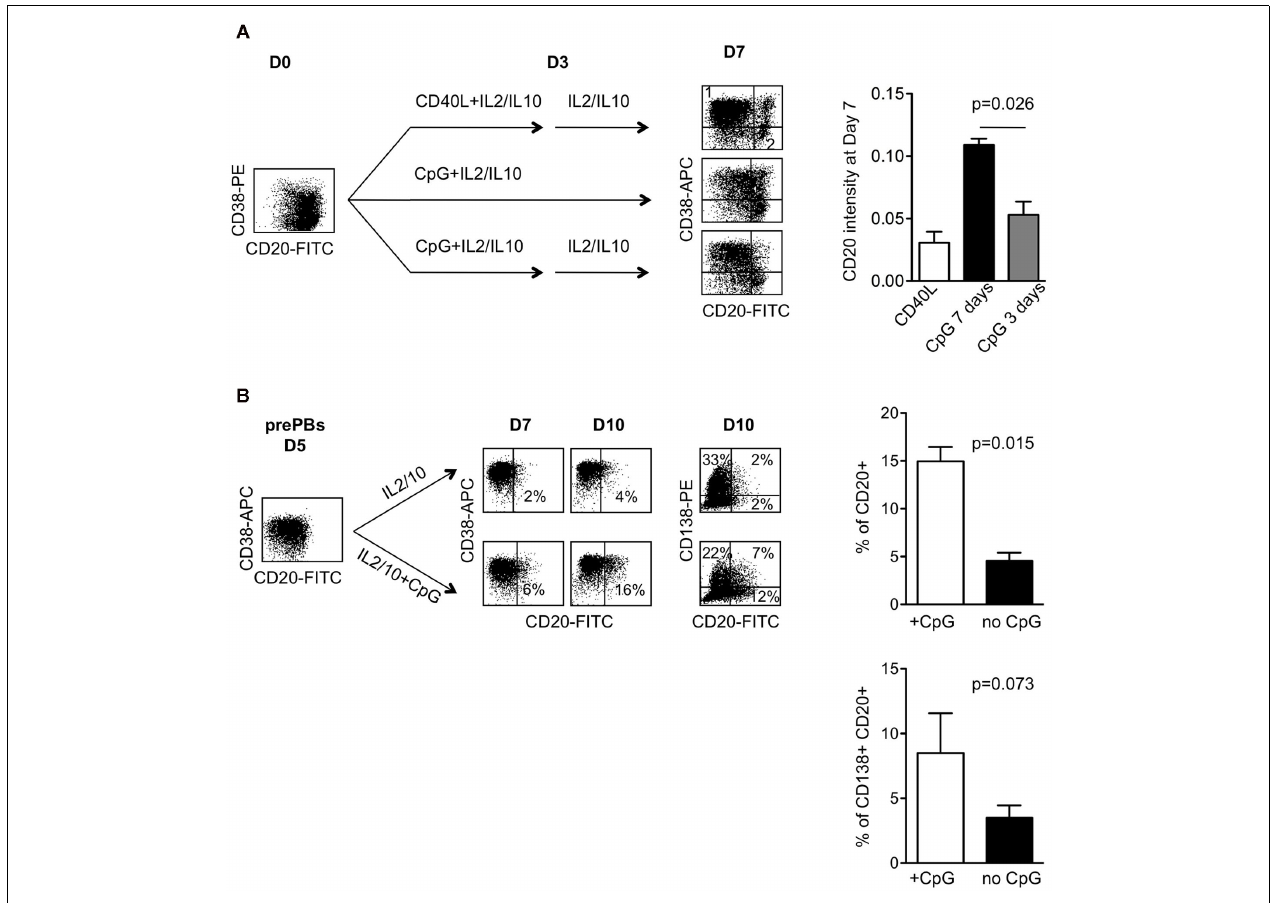
donors were cultured for 3days with CD40L-expressing fibroblasts in the presence of IL2 plus IL10 and then for 2days with IL2 plus IL10 in the presence of anti-CD40L mAb.The remaining CD20 ++ B-cells were removed to obtain a pure population of prePB cells engaged in differentiation (see Materials and Methods). PrePBs (Day 5) were then cultured in the presence of IL2 plus IL10 with or without CpG2006.The CD20 phenotype of PBs and PCs was analyzed 2 (Day 7) to 5 (Day 10)days after in double or triple staining. Representative experiment out of three. Right: data represent the proportion at Day 10 of CD20 + (upper panel) and of CD20 + CD138 + (lower panel) in the culture with or without CpG (data represent the mean ± SD of three independent